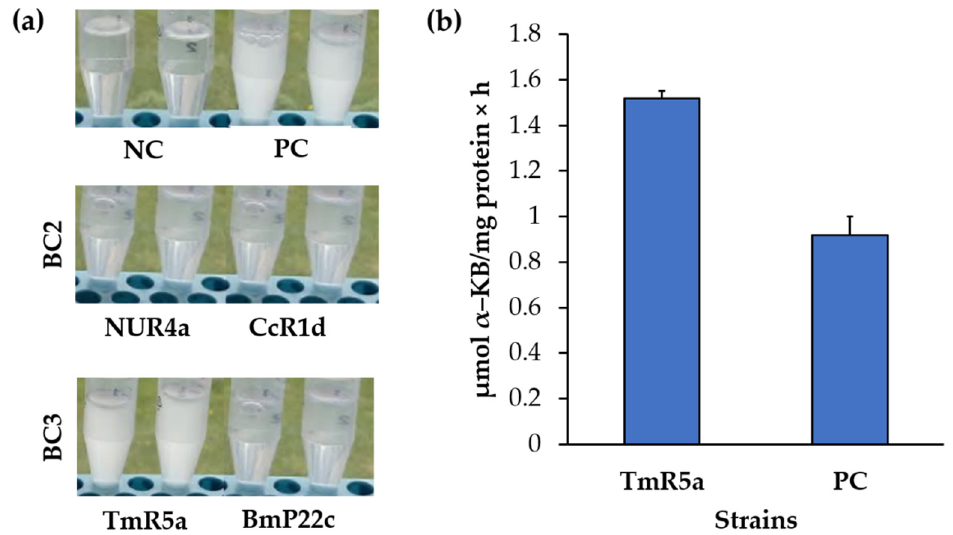
Figure 9. Growth in ACC and ACC deaminase activity of bacterial strains. ( a ) Growth in DF medium with ACC addition as sole carbon and nitrogen source. ( b ) ACC deaminase activity in µmol α -KB mg protein − 1 h − 1 of strains with positive growth. Each value is a mean ± SD of three independent replicates. Abbreviations: NC, negative control; PC, positive control ( Achromobacter sp. 188); BC, bacterial consortium; ACC, 1-aminocyclopropane-1-carboxylic acid; α -KB, α -ketobutyrate.